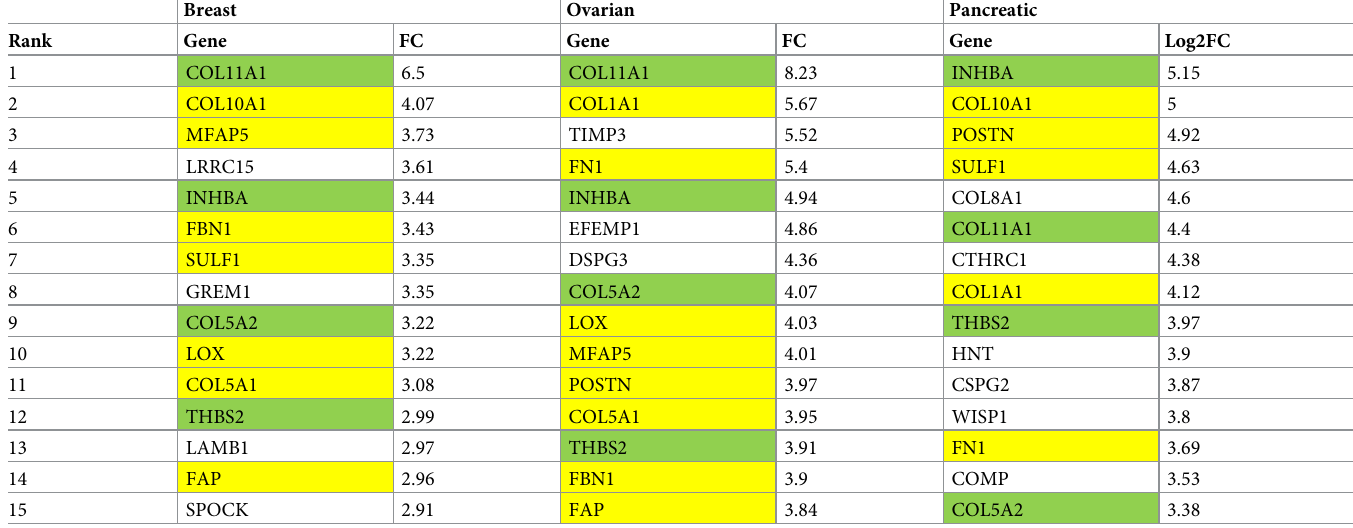
Table 1. Top 15 ranked genes in terms of fold change (FC) for three different cancer types revealing the signature of the COL11A1 -expressing cancer-associated fibroblasts. Shown are the rankings, reported by the authors, for breast, ovarian and pancreatic cancers. We eliminated multiple entries of the same gene (keeping the one that appears first) and dashes. Genes shared in all three cancer types are highlighted in green, while genes appearing twice are highlighted in